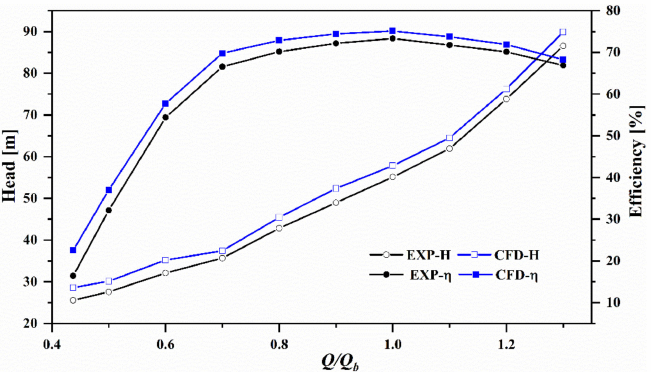
Figure 6. Hydraulic performance characteristics comparison between CFD and experiment.